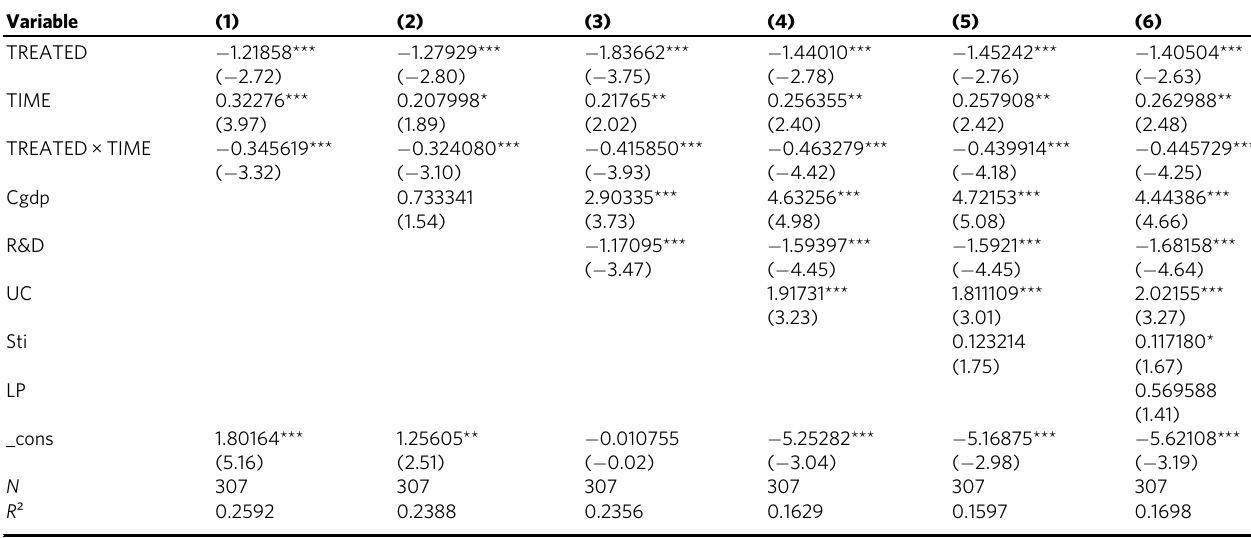
Table 3 In fl uence of the B&R policy on the GD level of construction enterprises — DID.